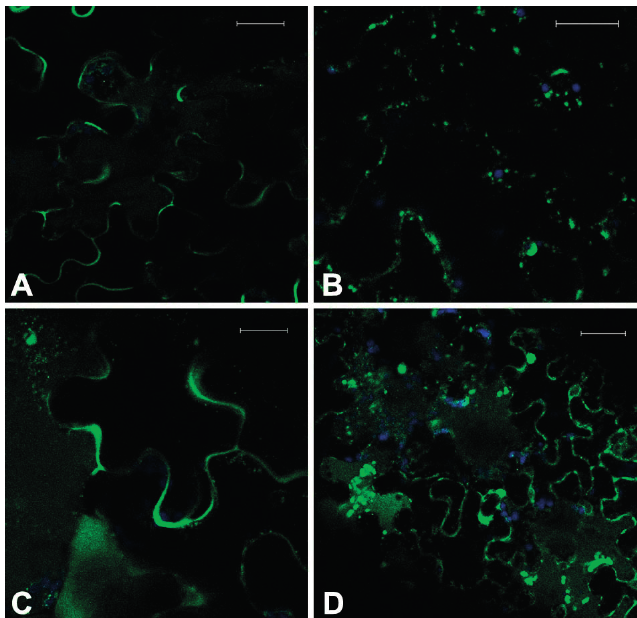
Figure 3. Fluorescent patterns of GFPChi in transgenic Arabidopsis leaf epidermis treated with low doses of two combined drugs. Treatment with 0.2 μ M Crizotinib had a moderate effect on GFPChi ( A ); but it was enhanced when combined with 10 μ M Paclitaxel disturbing intermediate steps of its sorting ( B ) or causing mis-sorting to the apoplast when combined with 25 μ M Y-27632 ( C ); combined treatment with 0.01 μ M Sorafenib caused the increase of fluorescence in the central and small vacuoles ( D ). GFP fluorescence